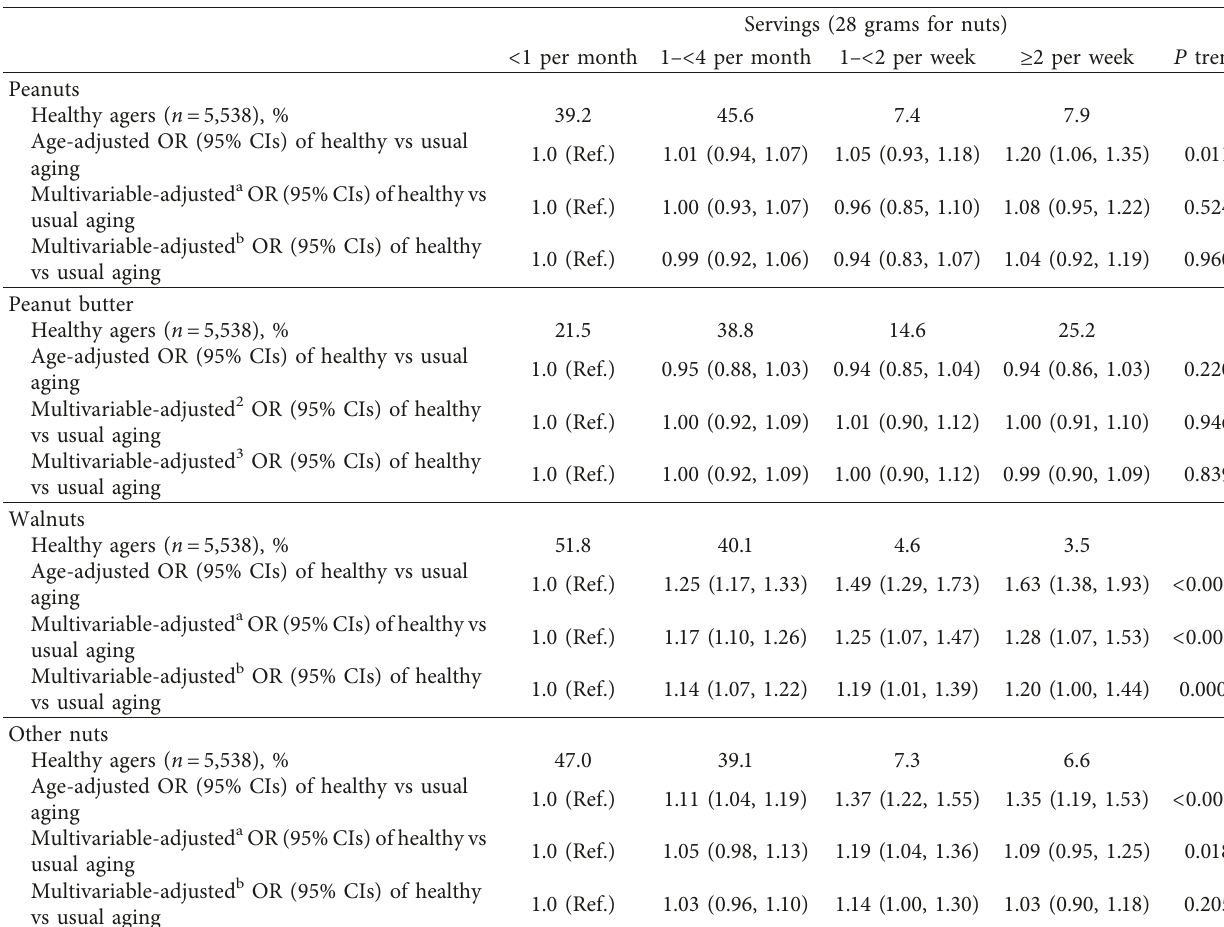
Servings (28 grams for nuts)